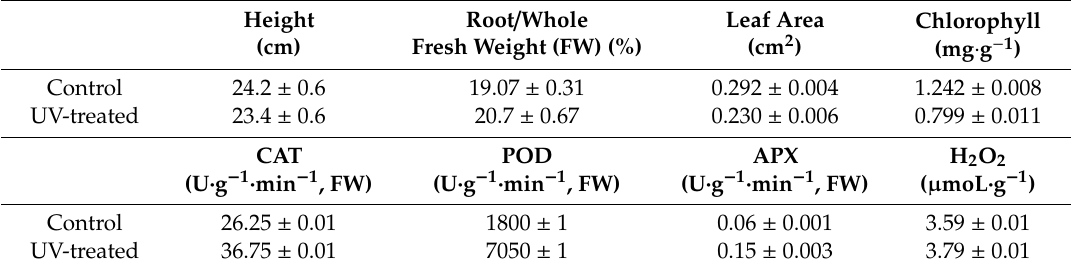
Table 2. Morphological and physiological indices of control and Ultraviolet treatments ( n =